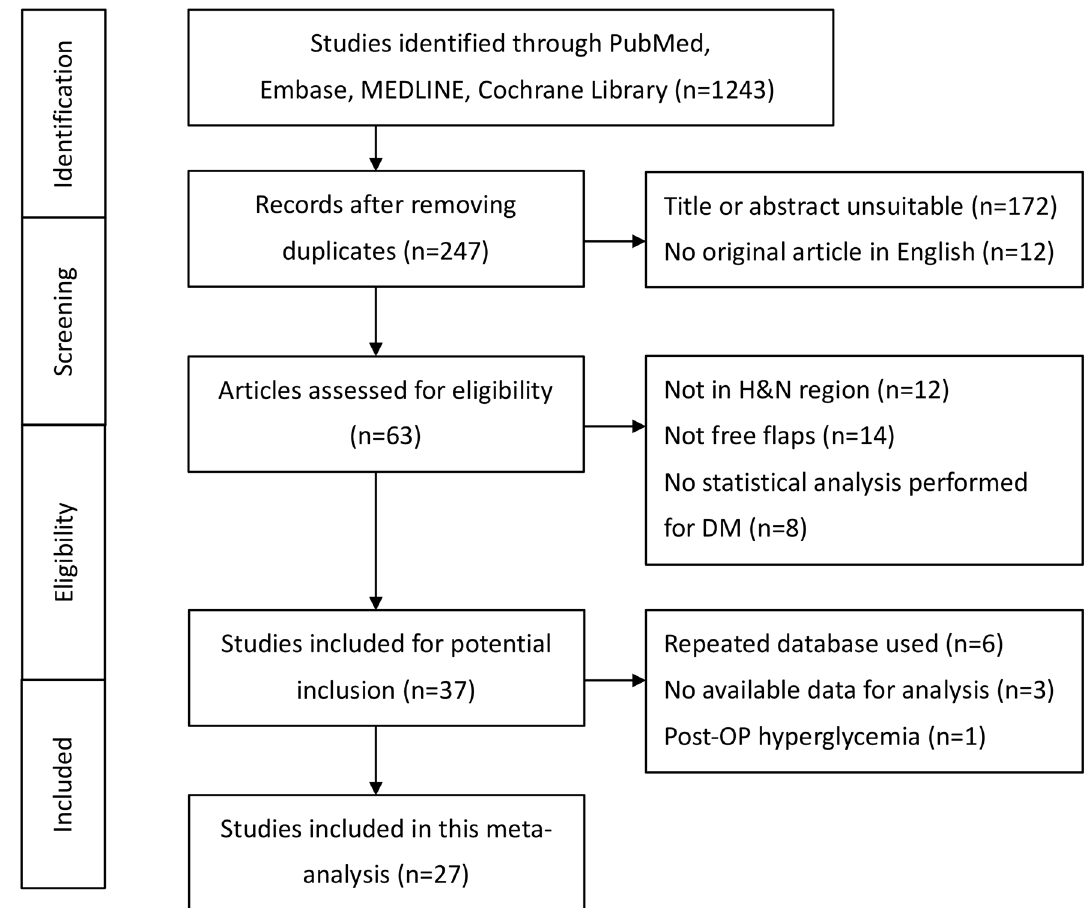
Figure 1. The flow diagram shows the process of enrolling studies for the